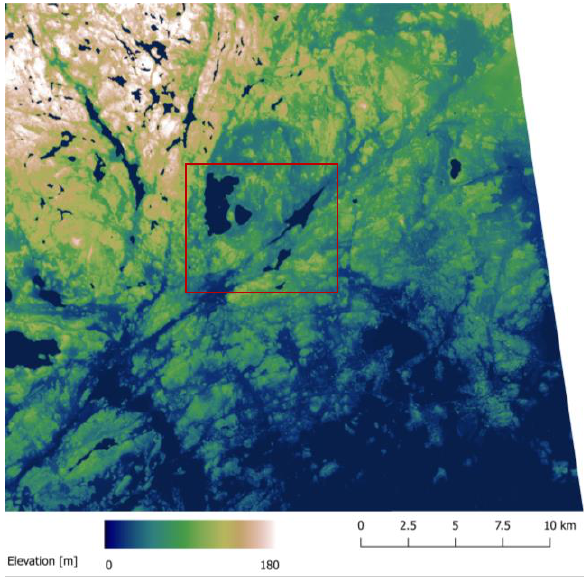
Figure 5: Final DEM of the whole test area after post processing, red square indicates location of Figure 3 The water areas extracted from the Sentinel-2 image solve the problem of artefacts in the water areas by masking them out. However, shore areas and water areas that do not cover a whole Sentinel-2 resolution cell are not covered consistently. This comes due to the fact that the water areas are determined through the green and SWIR channel, which have a resolution of 10 and 20 meter. Water areas often have a shallow transition to land areas, where the reflectance is not only water but also the ground or if present, vegetation.